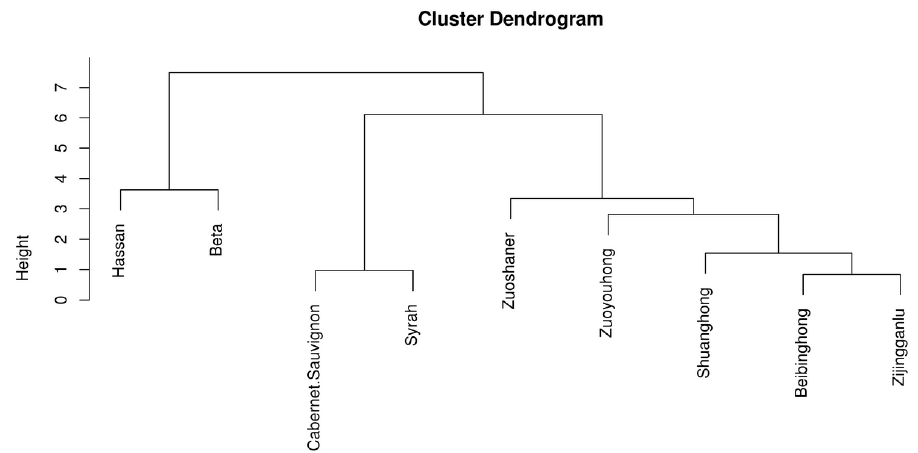
Figure 3. Cluster analysis chart of organic acid content in different wine samples.